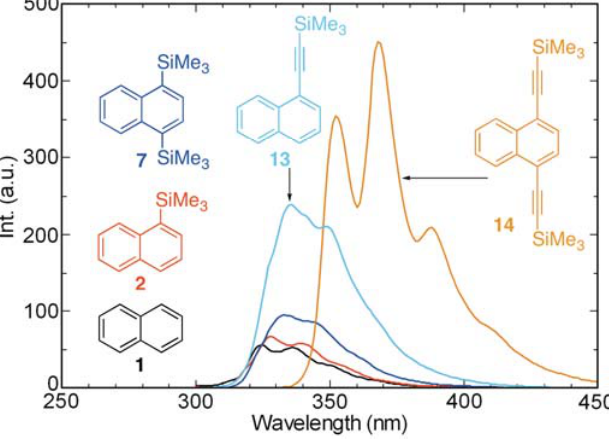
Figure 9. Fluorescence spectra of 1 , 2 , 7 , 13 , and 14 in cyclohexane (aerated, 10 − 4 –10 − 5 M).